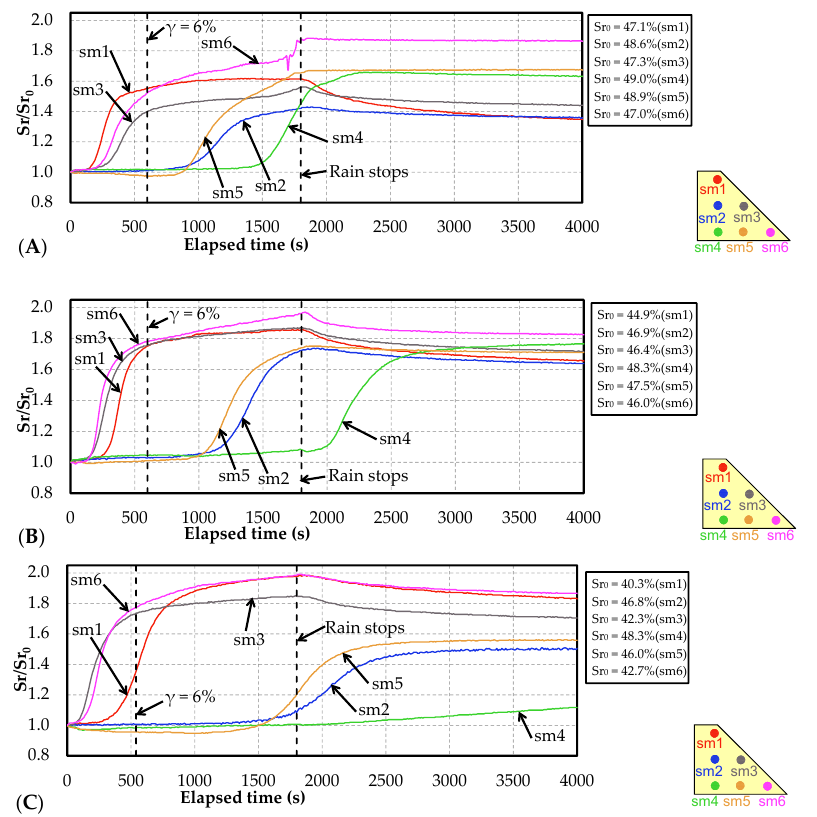
Figure 12. Changes in saturation degree during rainfall tests ( A ) K 8.5A, ( B ) K soil, ( C ) and K 40A .